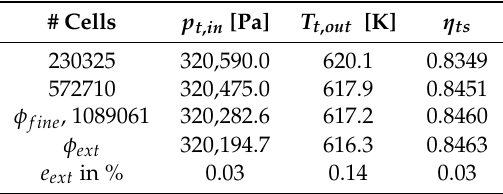
Table 3. Mesh study on CFD